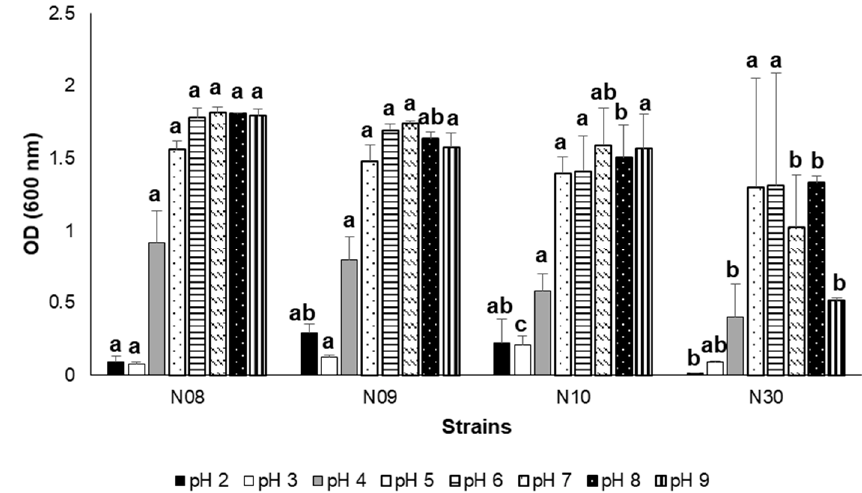
Figure 4. Effect of pH on growth of GABA producing-four strains. Values indicate the average ± standard deviation ( n = 3). Different letters denoted in column show significant difference ( p < 0.05).